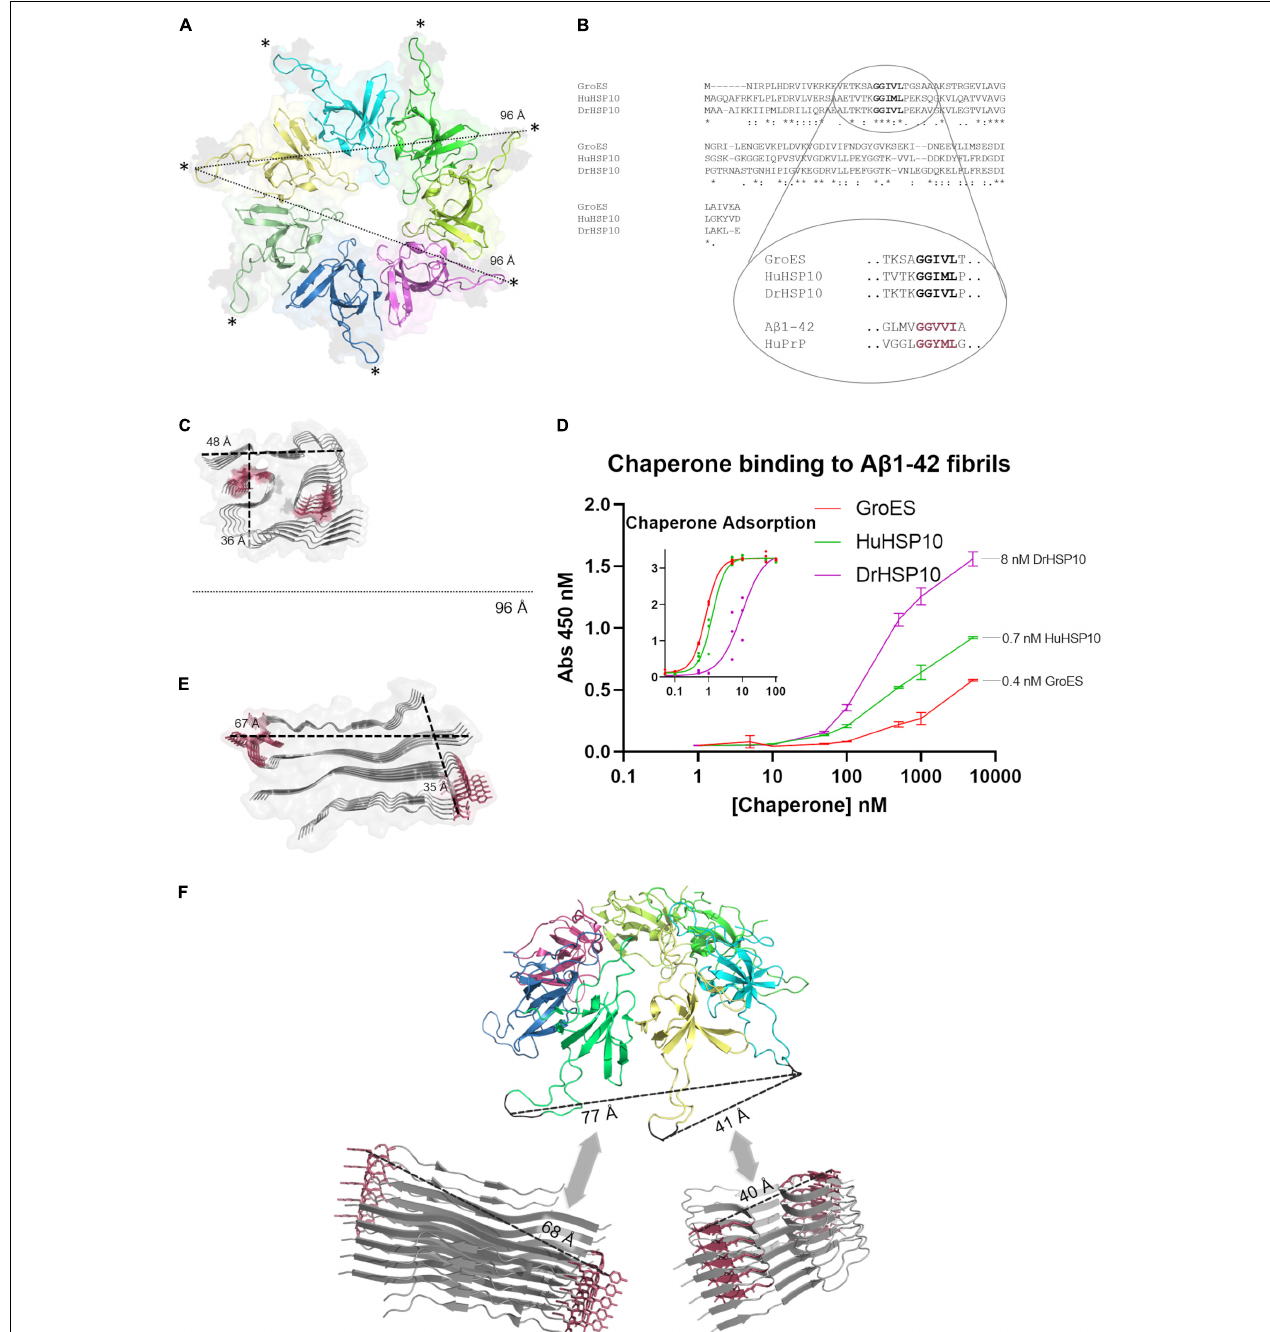
FIGURE 6 | Structural comparisons of HSP10s and amyloid filaments. (A) Ribbon diagram of the cryo-EM structure of HuHSP10 bound to human HSP60 (PDB code: 6MRC) (Gomez-Llorente et al., 2020). Each subunit in the heptamer is depicted in different colors. The maximum cross-distance between the mobile loops (highlighted with *) when structured and bound to HSP60 is 96 Å. (B) Multiple sequence alignment of GroES, HuHSP10, and DrHSP10 highlighting the conserved mobile loop sequence 29–33 (human numbering) GGIM(V)L. The mobile loop sequence is similar to amyloidogenic segments of A β (GGVVI 37–41) and PrP (GGYML 126–130) highlighted in red. (C) Structure of a filament type I polymorph from human brain A β 1–42 (PDB code: 7Q4B) (Yang et al., 2022) drawn to scale with (A) and the core segments 37–41 shown in red. (D) Relative HSP10 binding affinity and saturation to sonicated immobilized A β 1–42 fibrils. Error bars represent ± SD of triplicates. Inset [same x- and y-axes as in panel (D) ] shows a standard curve of HSP10 (0–100 nM) to estimate the concentration of HSP10 bound at the highest concentration of applied chaperone in the main figure (D) . (E) Structure of an amyloid filament of PrP106–145 (PDB code: 6UUR) (Glynn et al., 2020). The amyloidogenic segment 126–130 is highlighted in red. Drawn at scale with (A,C) . (F) Speculative structural illustration of how a heptameric molecule of HSP10 could recognize fibril ends of a A β 1–42 (bottom right) and PrP106–145 (bottom left) by multiple binding of mobile loops fitting within variable distances depending on fibril structure. All protein structure images were made with